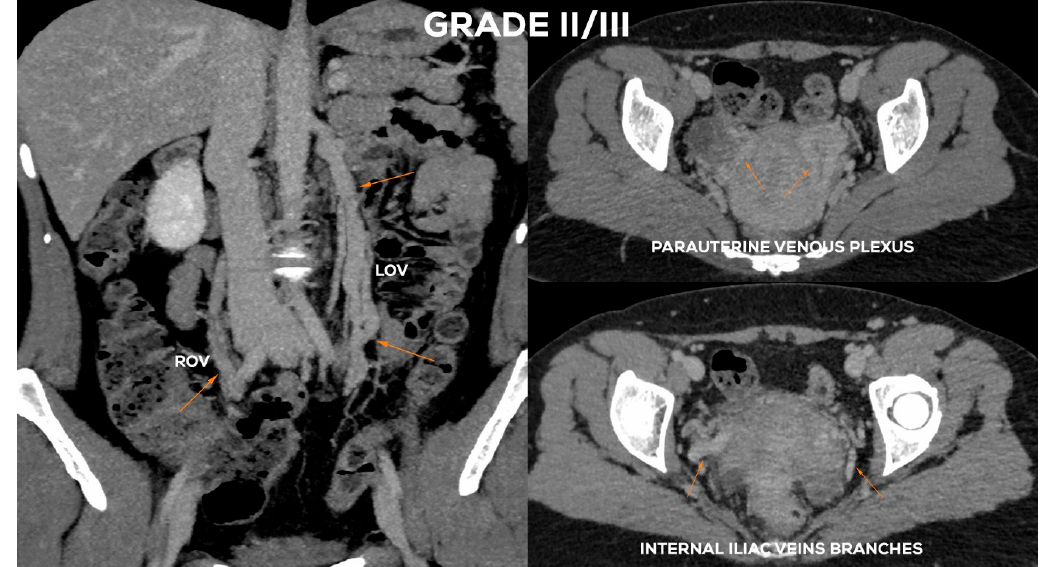
Figure 13. Typical findings in patient with Grade II/III ovarian veins insufficiency seen on CTV images in coronal and axial planes.